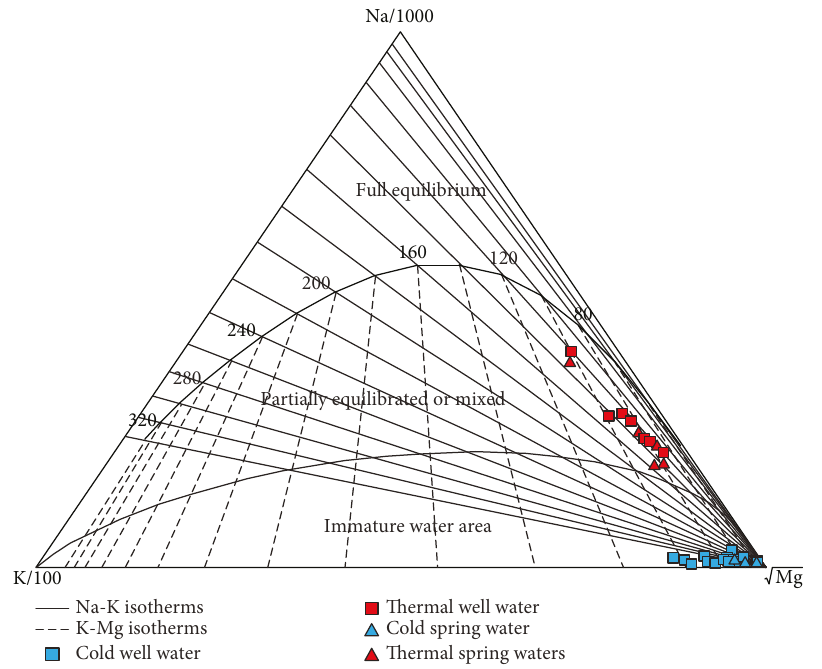
Figure 5: Na-K-Mg diagram for geothermal water samples in the research area.